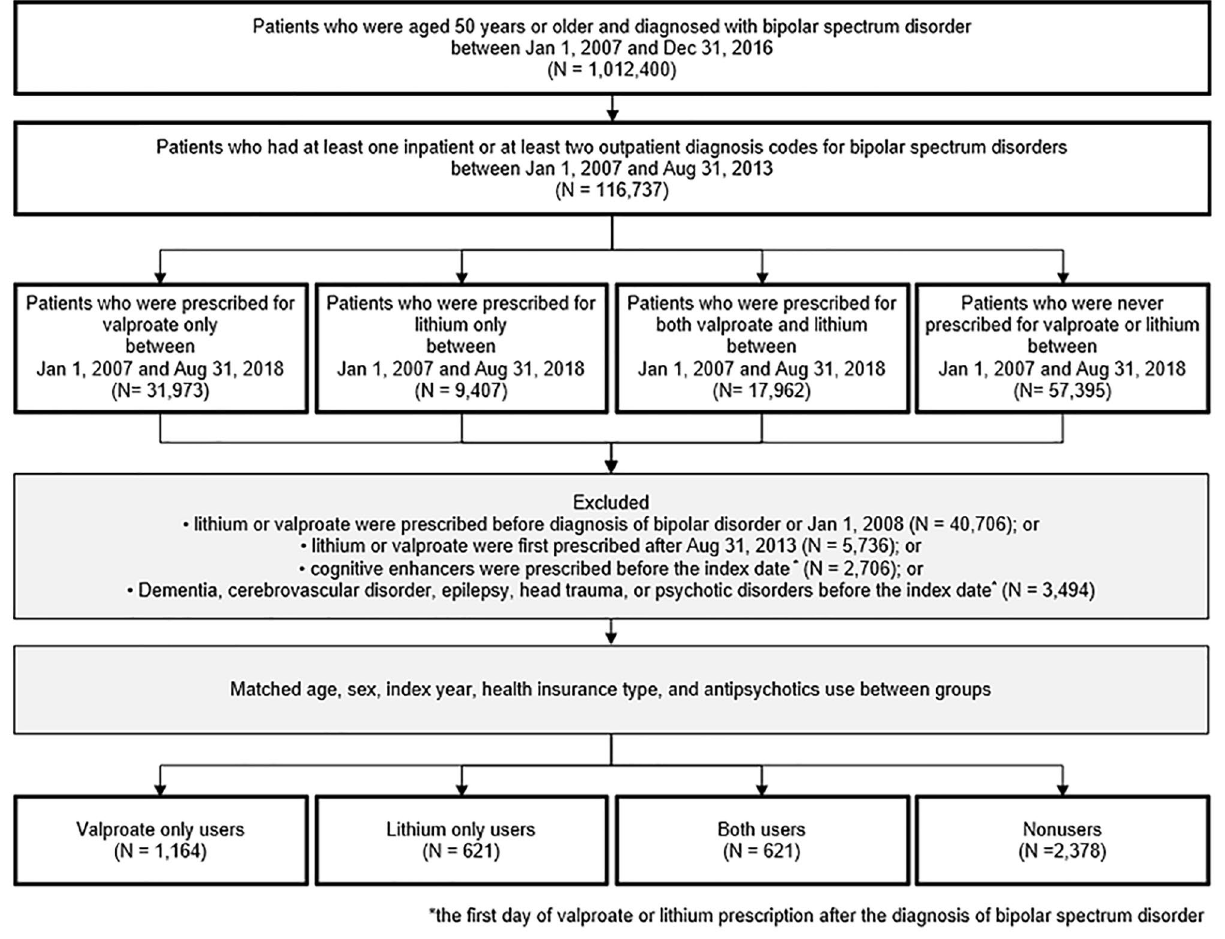
Figure 1. Assembly of study cohort with valproate only users, lithium only users, both valproate and lithium users, and